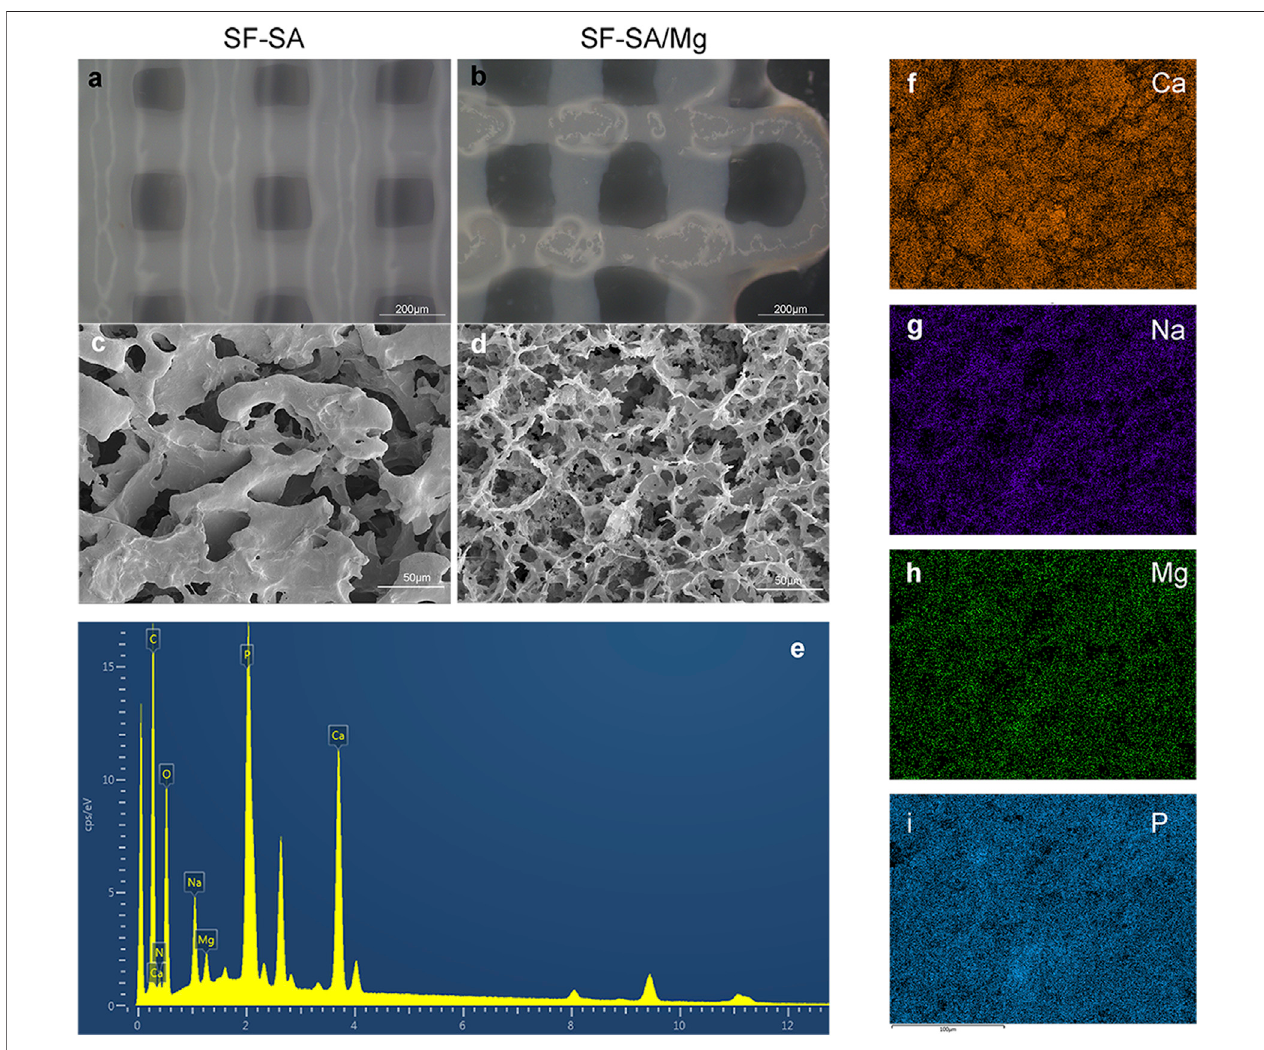
FIGURE5| Images of3D-printed SF-SA (A) and SF-SA/MgP (B) scaffoldsunderstereoscopy,SEMimages ofthe surfacemorphology ofSF-SA (C) hydrogel and SF-SA/MgP (D) scaffolds. (E – I) : the surface of EDS of SF-SA/MgP scaffold.